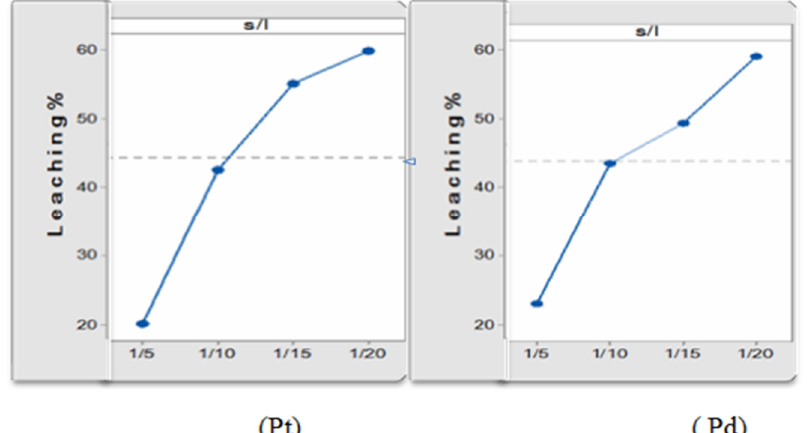
Fig. 6. Efficiency of platinum and palladium leaching by aqua regia solution for each level as a function of solid/liquid